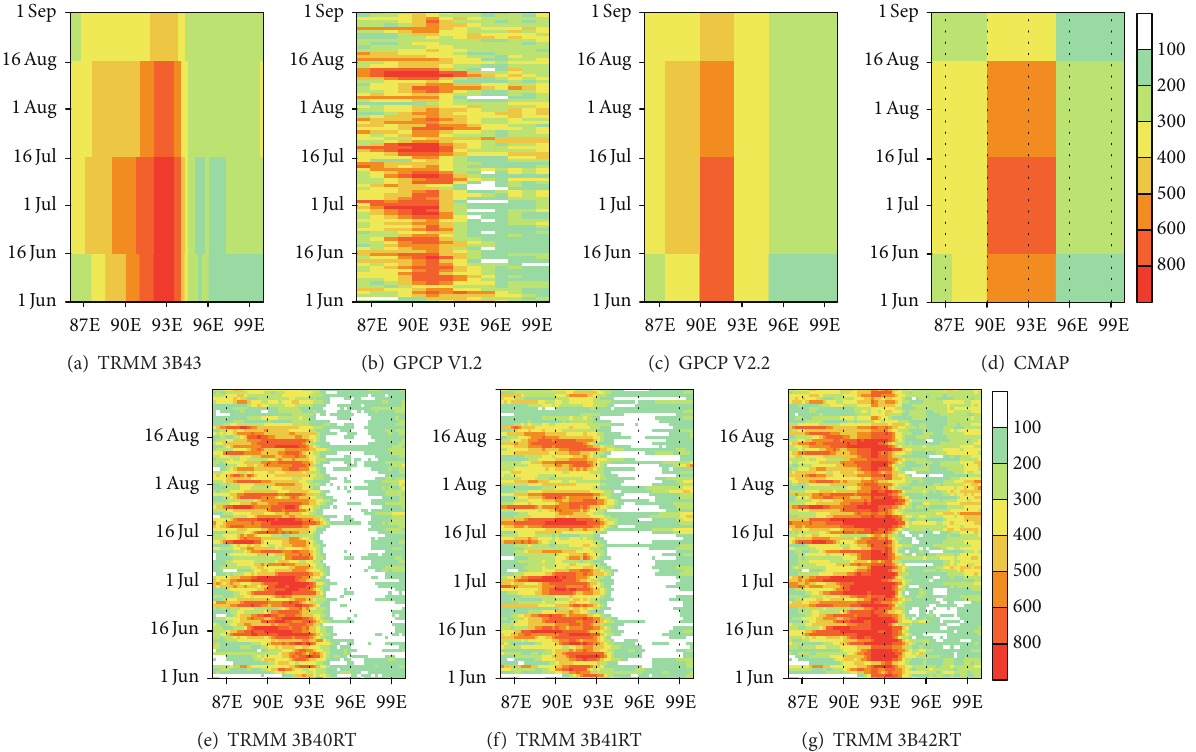
Figure 2: Climatological mean seasonal evolution of precipitation (mmmonth −1 ) in JJA averaged in the latitudinal band of 19 ∘ –21 ∘ N from various precipitation products as indicated in each panel.